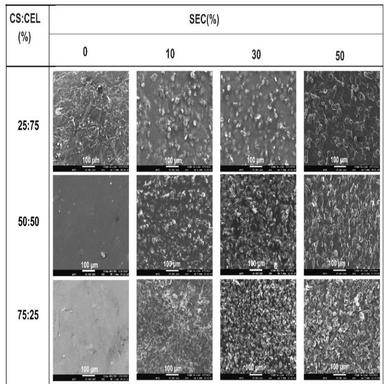
SEM images of CS:CEL composites loaded with different amounts of SEC.